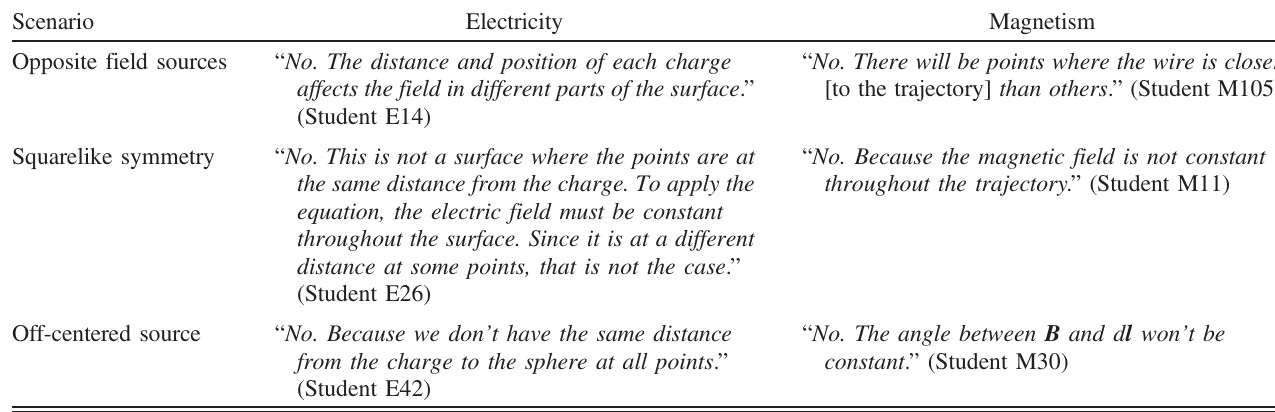
TABLE II. Examples of students ’ reasoning in the category lack of symmetry for each